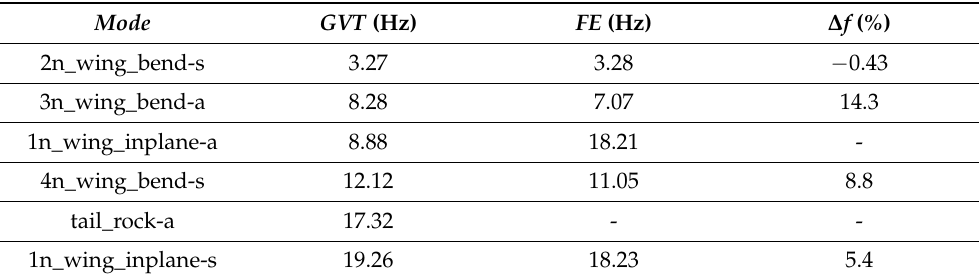
Table 3. Comparison of eigen frequencies: GVT vs. stiffness-updated FE model (in—i nodes in the mode, s—symmetric,